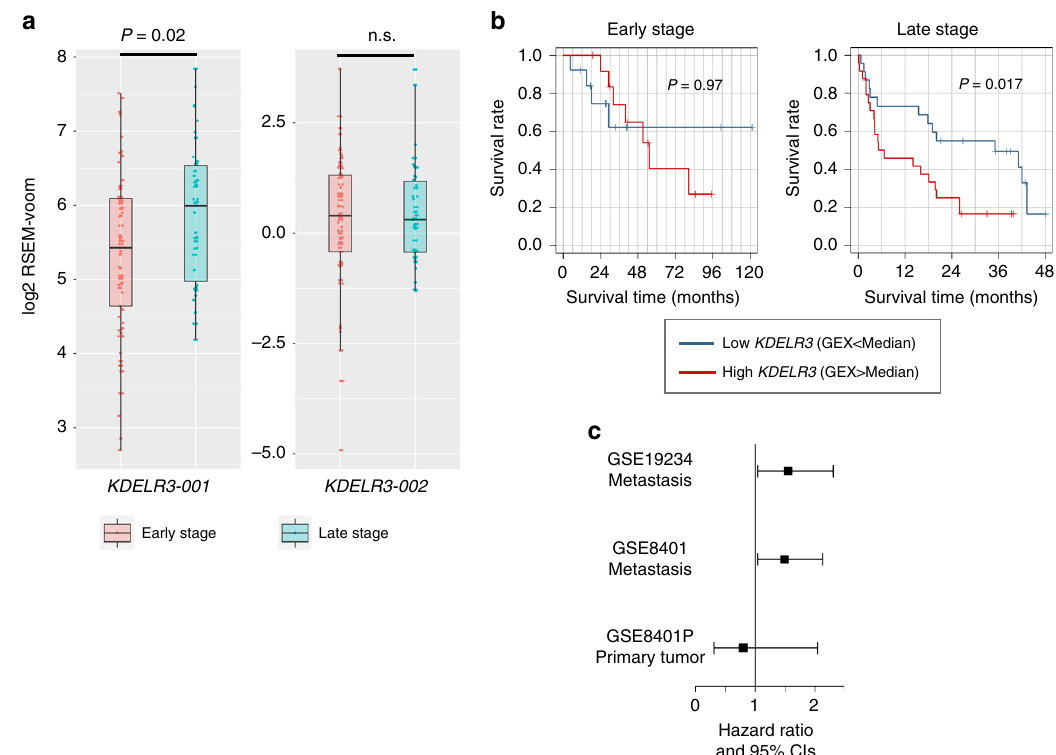
Fig. 6 KDELR3 expression correlates with advanced metastatic disease in patients. a KDELR3-001 and KDELR3-002 patient expression data. Empirical Bayes moderated t -statistic (unpaired two-tailed test); KDELR3-001 , ENST00000216014, P = 0.0202, t = 2.36, d.f. = 102.17; KDELR3-002 , ENST00000409006, P = 0.87, t = 0.16, d.f. = 102.17. Boxplots of patient expression data from TCGA-SKCM dataset, depicting the 25th, 50th (median), and 75th percentile, and extreme values of the transcript expression. “ Early ” stage (stages I/II, N = 62 patients). “ Late ” stage (stages III/IV, N = 39 patients). n.s., not signi fi cant. b Kaplan – Meier estimated survival curves according to KDELR3 expression in early-stage (GSE8401; n = 27, stages I/II) and late-stage (GSE8401; n = 47, stages III/IV) melanomas. Log-rank test. c Association of KDELR3 expression and survival in metastatic melanoma (GSE19234, n = 38; GSE8401, n = 47, stages III/IV); HR = 1.62 ( P = 0.028) and HR = 1.49 ( P = 0.032) for GSE19234 and GSE8401, respectively. No signi fi cant association was found in the primary tumors (GSE8401, n = 27, stages I/II); HR = 0.76 ( P = 0.509). Cox regression model was used to test the